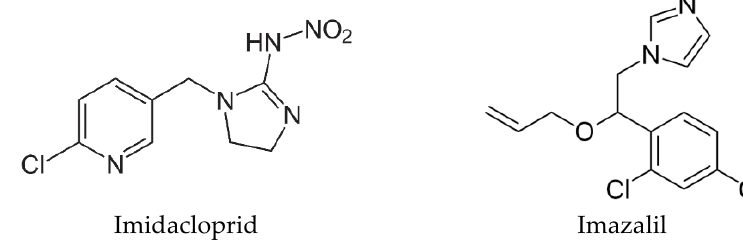
Figure 1. Chemical structure of glyphosate, imidacloprid and imazalil.